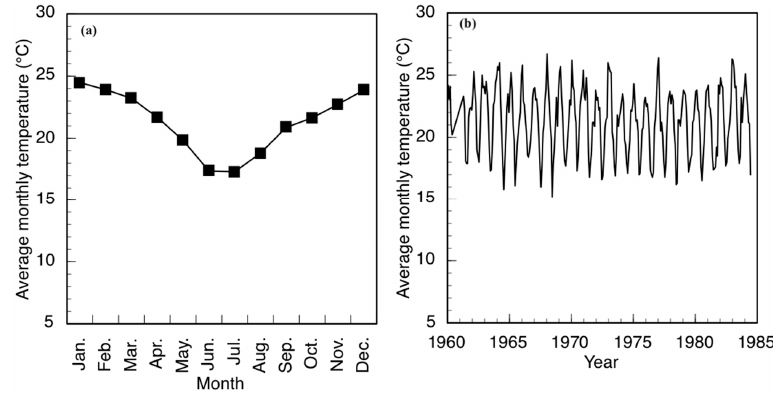
Figure 2. Precipitation trends in the study area. ( a ) Annual precipitation by hydrologic year. Data quality are presented on a scale of zero to unity where the quantity shown represents the proportion of missing or unreliable data in a year; ( b ) Cumulative precipitation for the last five complete years; ( c ) Average monthly precipitation calculated for years with greater than 90% reliable data (bottom right). All data are presented by the standard Southern hemisphere hydrologic year from July to June numbered with the ending year. Data are from the Nwanedzi Natural Reserve at the Luphephe Dam (17 km from the study area) and are available through the Republic of South Africa, Department of Water and Sanitation, Hydrologic Services (http://www.dwa.gov.za/Hydrology/).